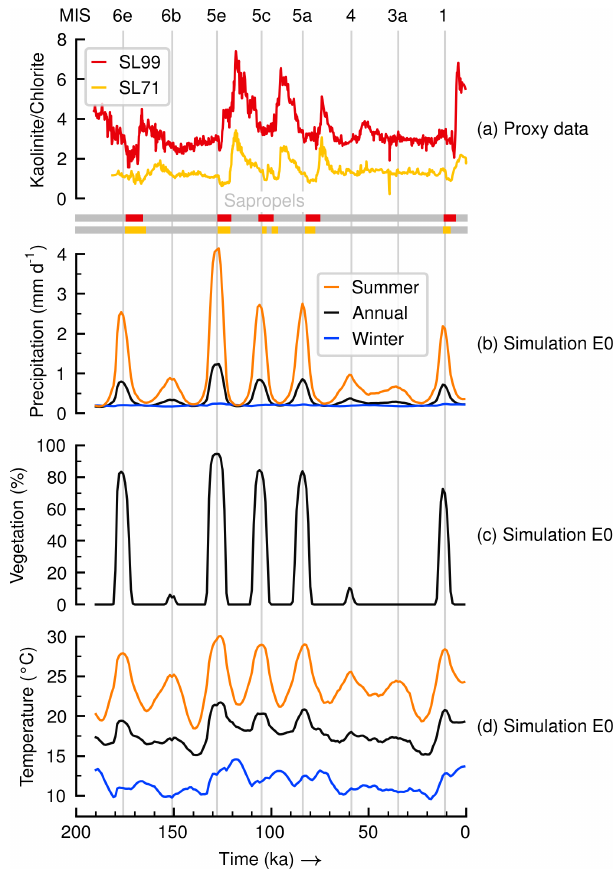
Figure 2. Comparison of (a) proxy data with (b, c, d) results from control simulation E0 in the Sahara grid box: annual and sea- sonal means of (b) precipitation, (c) vegetation cover fraction and (d) near-surface temperature. Proxy data are ratios of clay miner- als and sapropel layers from sediment cores SL71 and SL99 from the eastern Mediterranean Sea described in Ehrmann and Schmiedl (2021). Vertical lines indicate maxima in the monsoon forcing index and are labelled using MIS names on